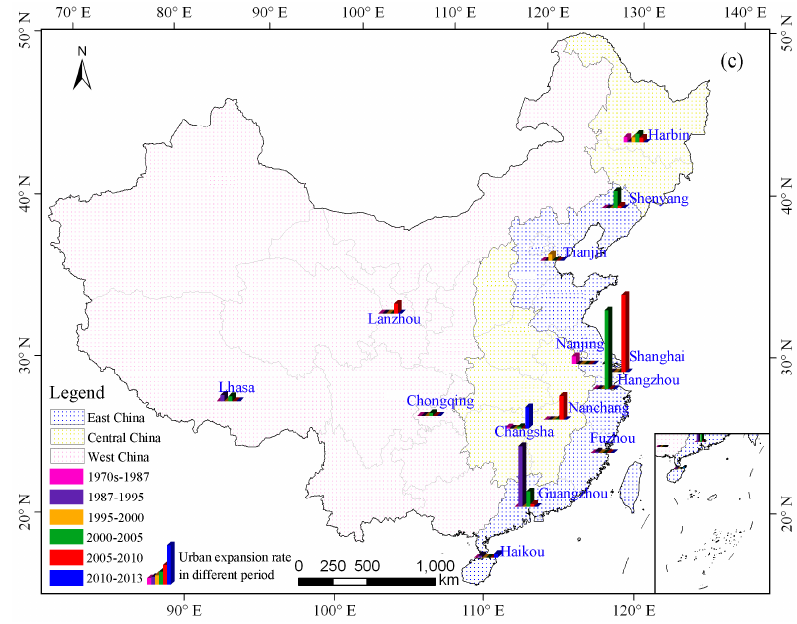
Figure 8. Urban expansion rate by the three forms in the 31 sample cities in six periods: ( a ) edge-expansion form; ( b ) infilling form; ( c ) leapfrog